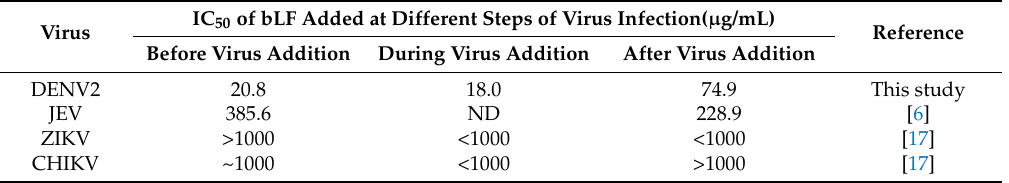
Table 2. Half maximal inhibitory concentration (IC 50 ) of bLF added at different steps of virus infection.